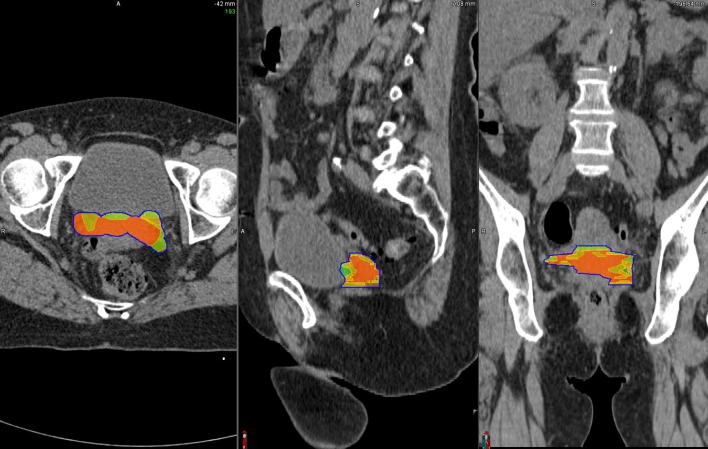
Spatial distribution of all hotspots obtained after deformable registration of the PET imaging sets with a single planning CT. Volumes in red representing the presence of > 75% hotspots, orange 50–75%, yellow 25–50% and green < 25%. (For interpretation of the references to colour in this figure legend, the reader is referred to the web version of this article.)